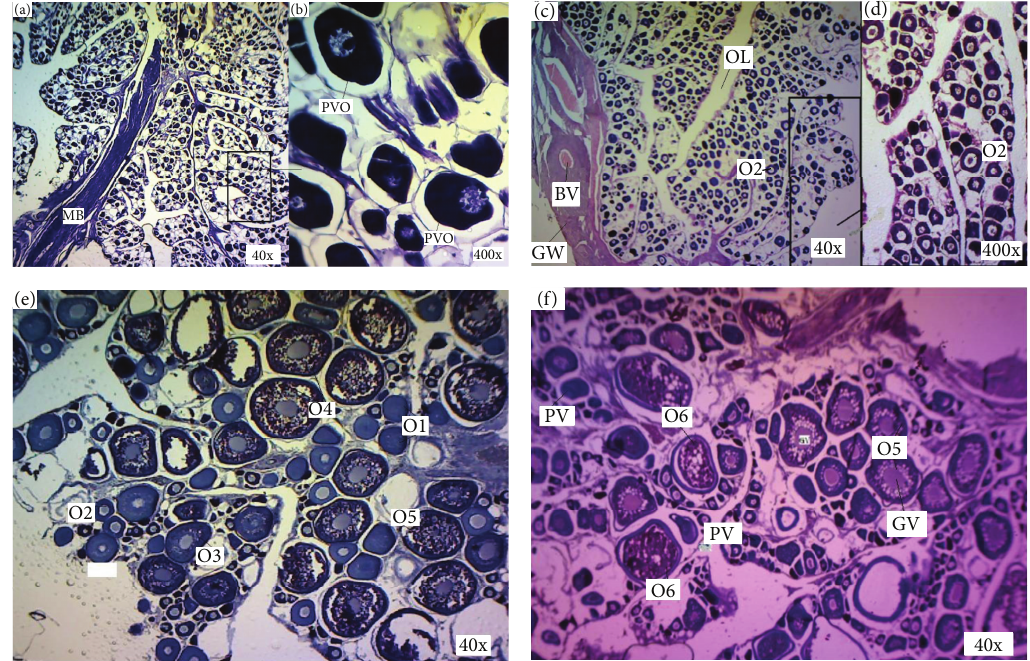
Figure 2: Histological section of ovarian stages of Epinephelus malabaricus (a) Immature (F1) collected 25 January 2010, 66 cm 𝐿 𝑇 , 5kg 𝑊 𝑇 , 4.4 g 𝐺 𝑊 (c) Mature ripening (F3) collected 28 February 2010, 79 cm 𝐿 𝑇 , 9kg 𝑊 𝑇 , 20g 𝐺 𝑊 ; (e) Late ripening (F4) collected 30 January 2010, 82 cm 𝐿 𝑇 , 9.5kg 𝑊 𝑇 , 124g 𝐺 𝑊 ; (f) Ripe (F5) collected 19 October 2010, 96.5 cm 𝐿 𝑇 , 16kg 𝑊 𝑇 , 185g 𝐺 𝑊 . PV: previtellogenic oocytes; OL: ovarian lumen; MB: muscle bundle, BV: blood vessel; GV: granule vesicle; GW: gonadal wall, O1–O6: oocytes stage